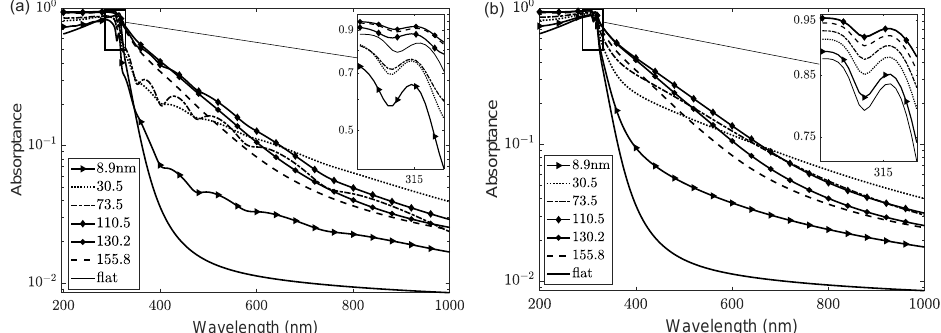
Figure 4. ( a ) Absorptance A as a function of wavelength for sample type 2 with various rms roughnesses of the ZnO/Ag interface on a logarithmic scale, including the ideal flat surface. The inset shows the silver plasmon resonance around 315 nm. ( b ) Same as ( a ) for constant Ag layer thickness of 500 nm.